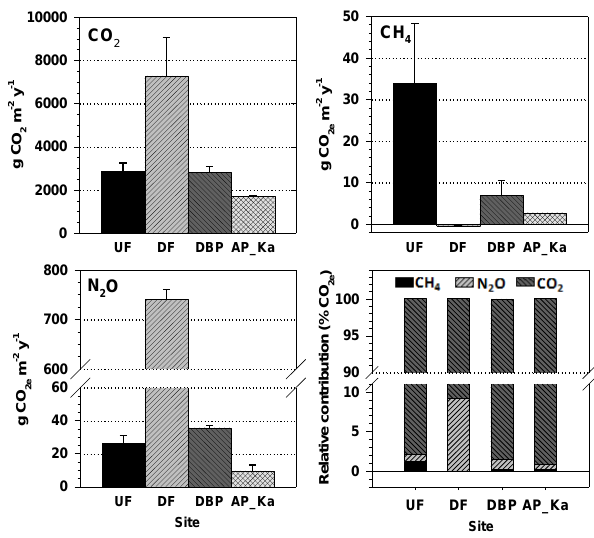
Fig. 5. Annual cumulative CO 2 , CH 4 and N 2 O-N fluxes (Mean ± SD) expressed as CO 2e equivalents (gCO 2e m − 2 yr − 1 ) in peat based on 100 years perspective in radiative forcing, i.e. CO 2 = 1, CH 4 = 25, N 2 O = 298 (Solomon et al., 2007). Relative contribu- tion of three gases to the total GWP (% CO 2e ) at sites is shown at lower right corner. Cumulative CO 2 and CH 4 flux rates and water table depth data; UF from Jauhiainen et al. (2005); DF and DBP from Jauhiainen et al. (2008), and AP Ka from Hirano et al. (2009).